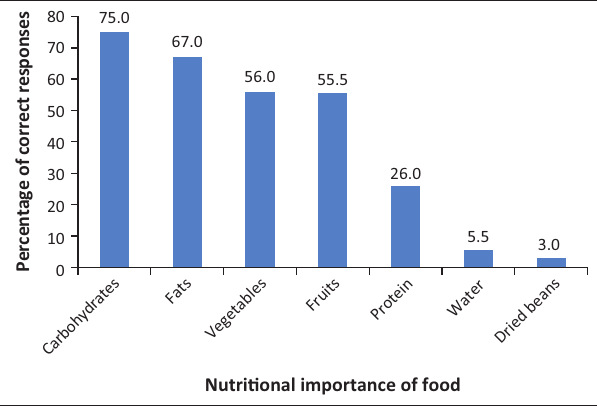
FIGURE 4: Percentage of correct responses on importance of